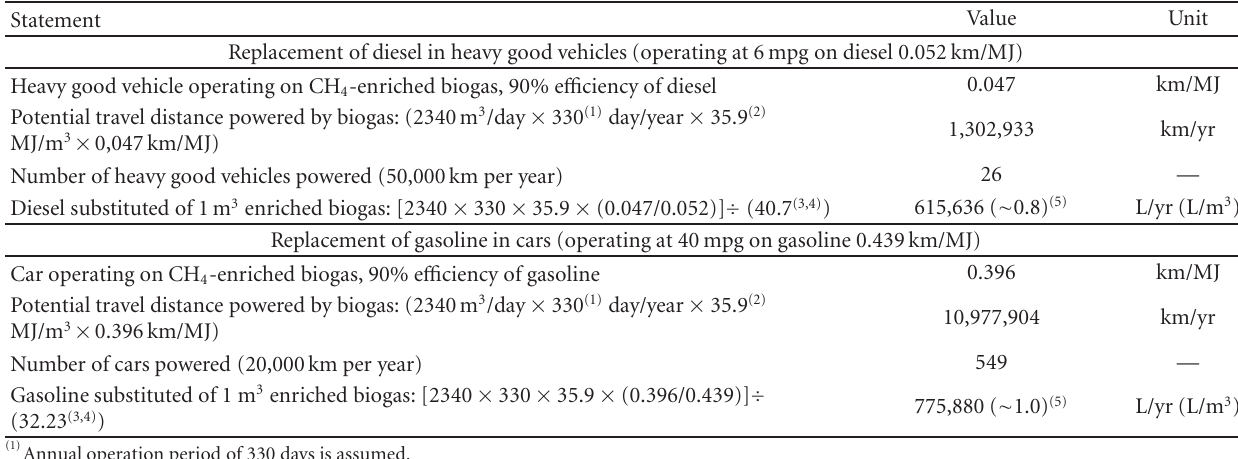
Table 3: Transport fuel substitutes of the produced biomethane (PE = 100,000; X PS = 61g TS/PE · day; X SS-OFMSW ) = 50g TS/PE · day)(adapted from Murphy et al.